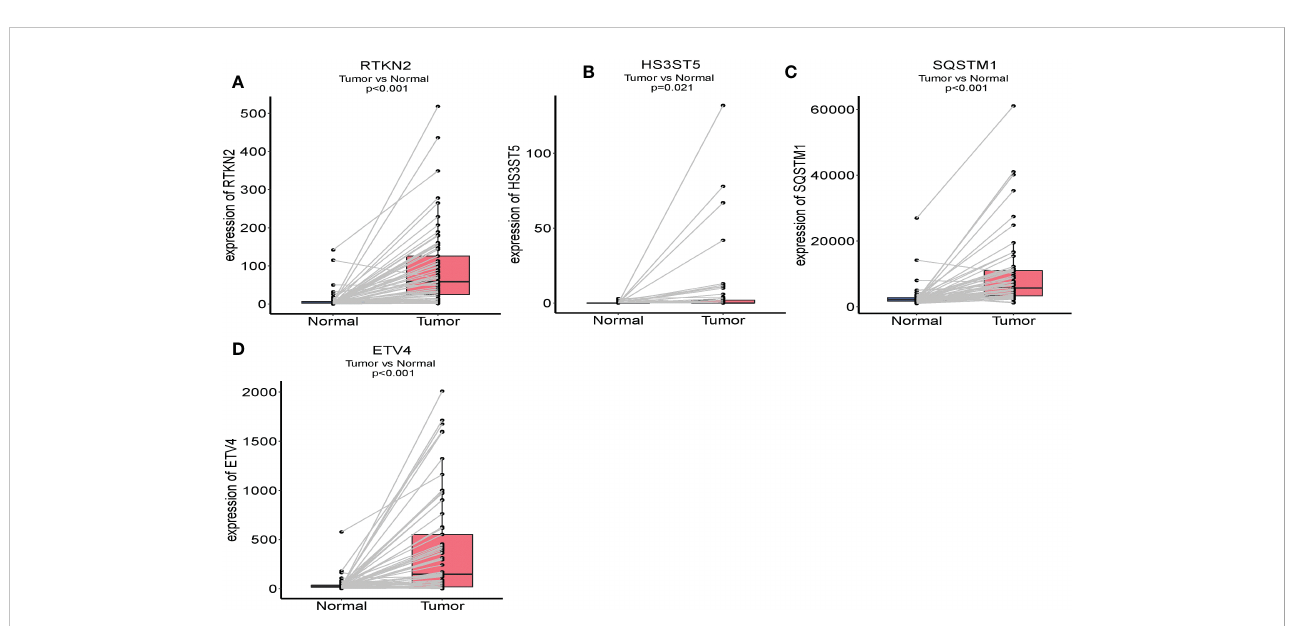
FIGURE 8 Comparison of the crucial genes mRNA levels in paired adjacent normal tissues and HCC tissues. (A) RTKN2; (B) HS3ST5; (C) SQSTM1; (D)